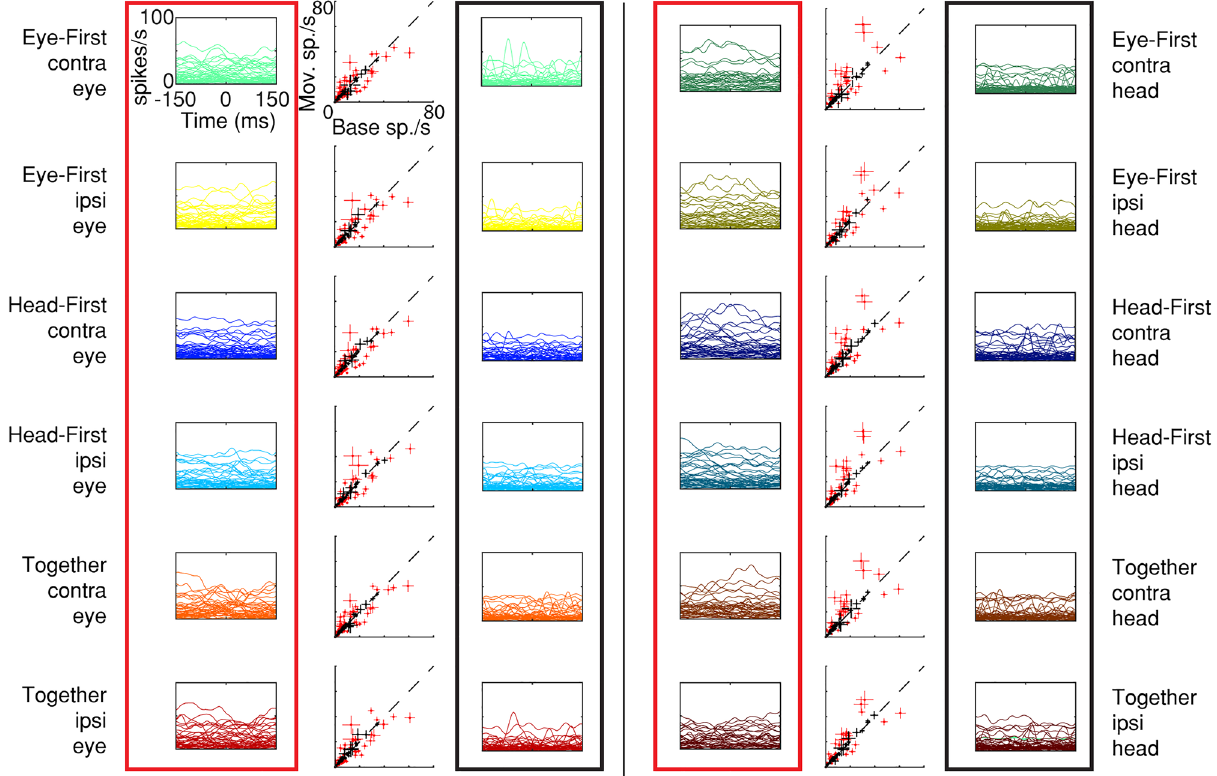
Figure 4. Distribution of cell responses during the movement epoch of each condition, grouped by statistical significance. Each scatter plot compares the trial-average activity during the movement epoch to the baseline period. Each point represents the mean and 95% confidence interval of one neuron. Red dots identify neurons with statistically significant modulation relative to baseline period, while black points denote cells that were not statistically modulated. The twelve scatter plots represent the 12 experimental categories, as denoted by text. The panels enclosed in the red boxes show temporal profiles of trial-averaged activity aligned on movement onset for the statistically modulated subset of neurons in the corresponding scatter plot. The panels within the black boxes show analogous data for the neurons that did not exhibit statistical